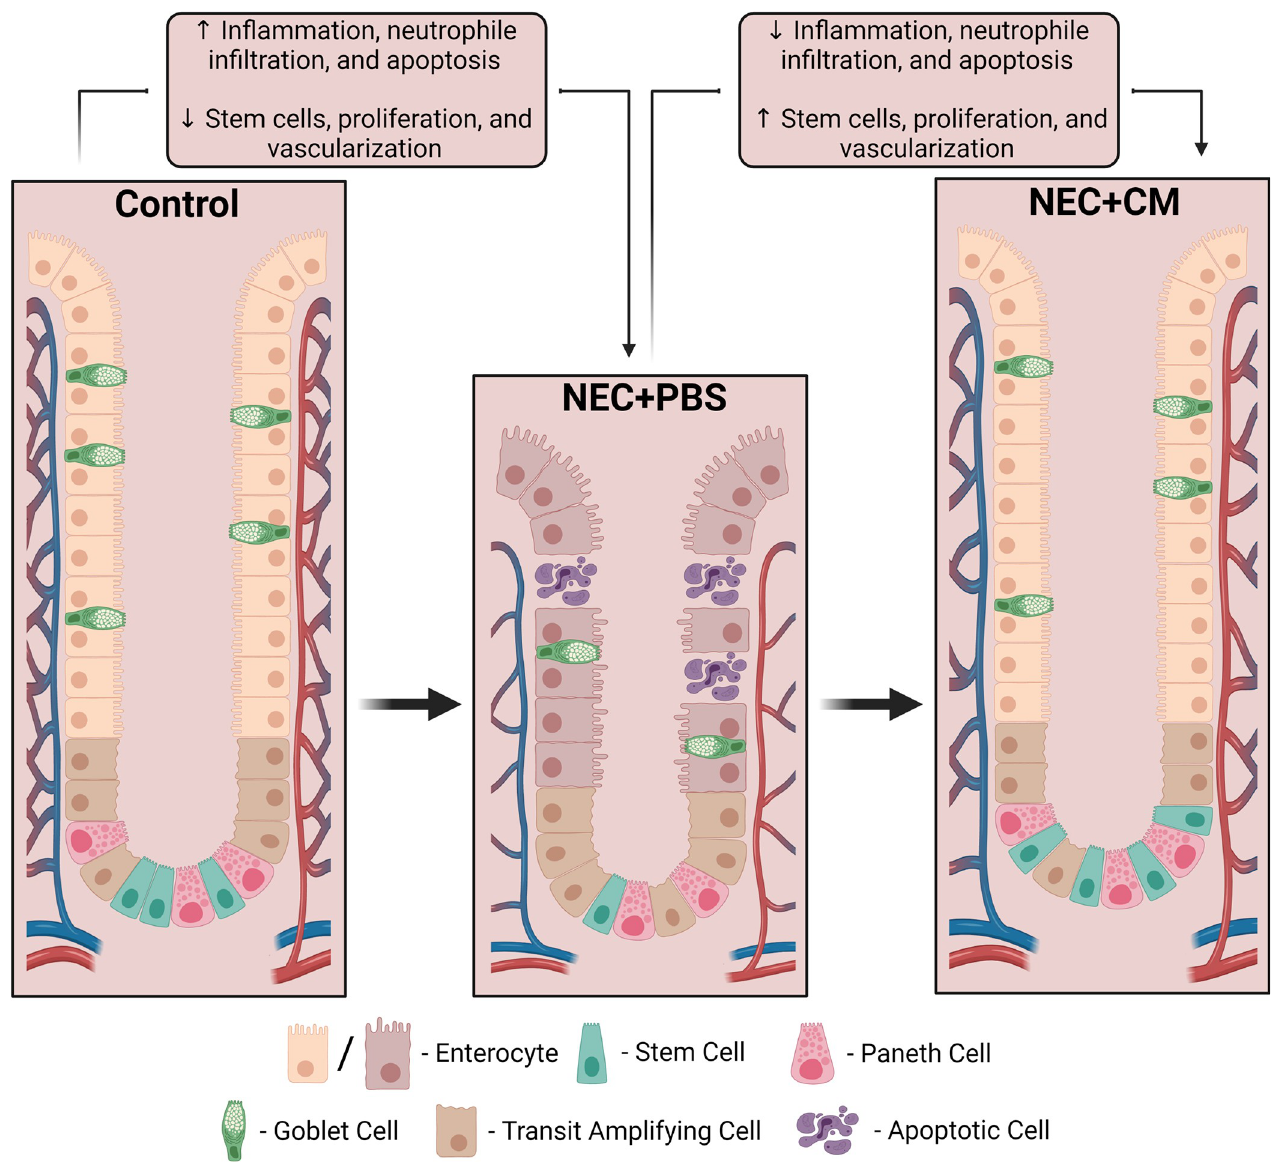
Fig 5. Summary of the role of AFSC-CM in experimental NEC. NEC induced an intestinal damage, increased inflammation (IL-6 and TNF- α ), neutrophil infiltration (MPO), and elevated apoptosis (CC3), as well as decreased angiogenesis or vascularization (VEGF). Further, it diminished epithelial proliferation (Ki67) and stem cell regeneration activity (Lgr5 and Olfm4), however, CM administration reverses all of these effects to yield reduced intestinal injury and improved